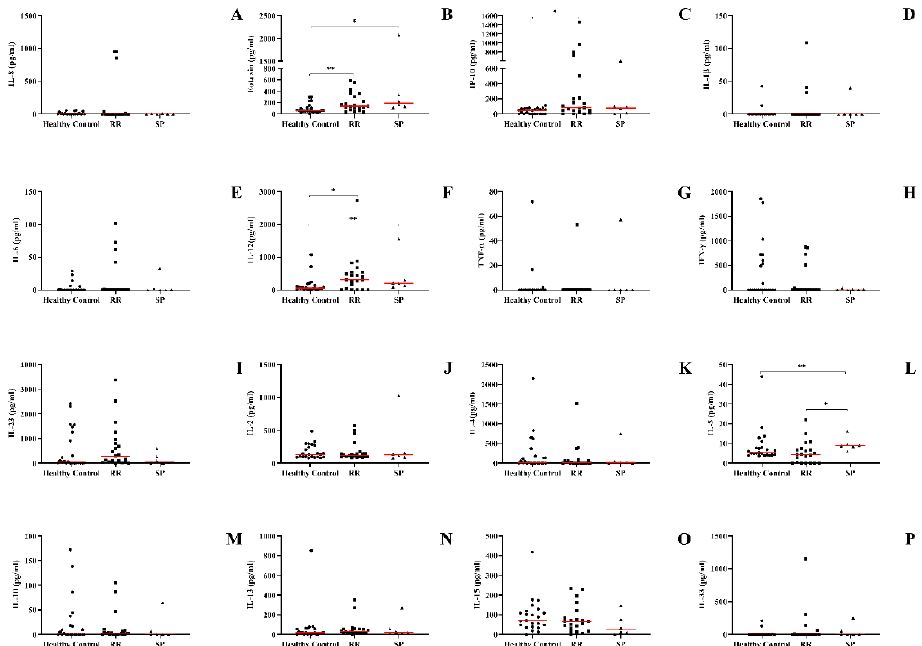
Figure 1. Concentration of cytokines and chemokines in the plasma of patients with multiple sclerosis according to the clinical form and compared to the group of healthy individuals and other neurological diseases obtained by enzyme-linked immunosorbent assay. ( A ) IL-8, ( B ) CCL-11/eotaxin-1, ( C ) CXCL-10/IP-10, ( D ) IL-1 β , ( E ) IL-6, ( F ) IL-12, ( G ) TNF- α , ( H ) IFN- γ , ( I ) IL-23, ( J ) IL-2, ( K ) IL-4, ( L ) IL-5, ( M ) IL-10, ( N ) IL-13, ( O ) IL-15 e ( P ) IL-33. Healthy control, RR (relapse–remitting multiple sclerosis), SP (secondary progressive), and sick control (other neurological diseases). Rows represent the median. Statistical analysis was performed using the Kruskal–Wallis test with Dunn’s post-test, where * and ** represent p < 0.05.